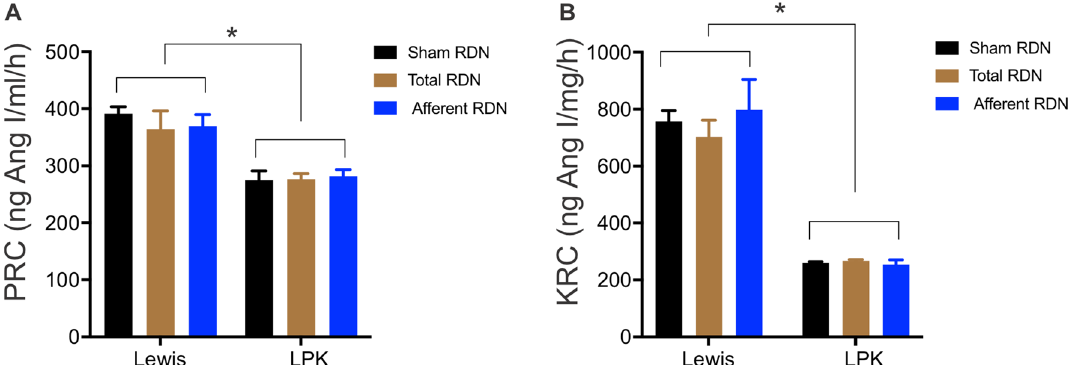
Figure 4. The effect of RDN on plasma renin content (PRC, A ) and kidney renin content (KRC, B ) in Lewis and LPK animals at 10 weeks of age. Data is expressed as mean ± SEM. *indicates P < 0.05 between strains as